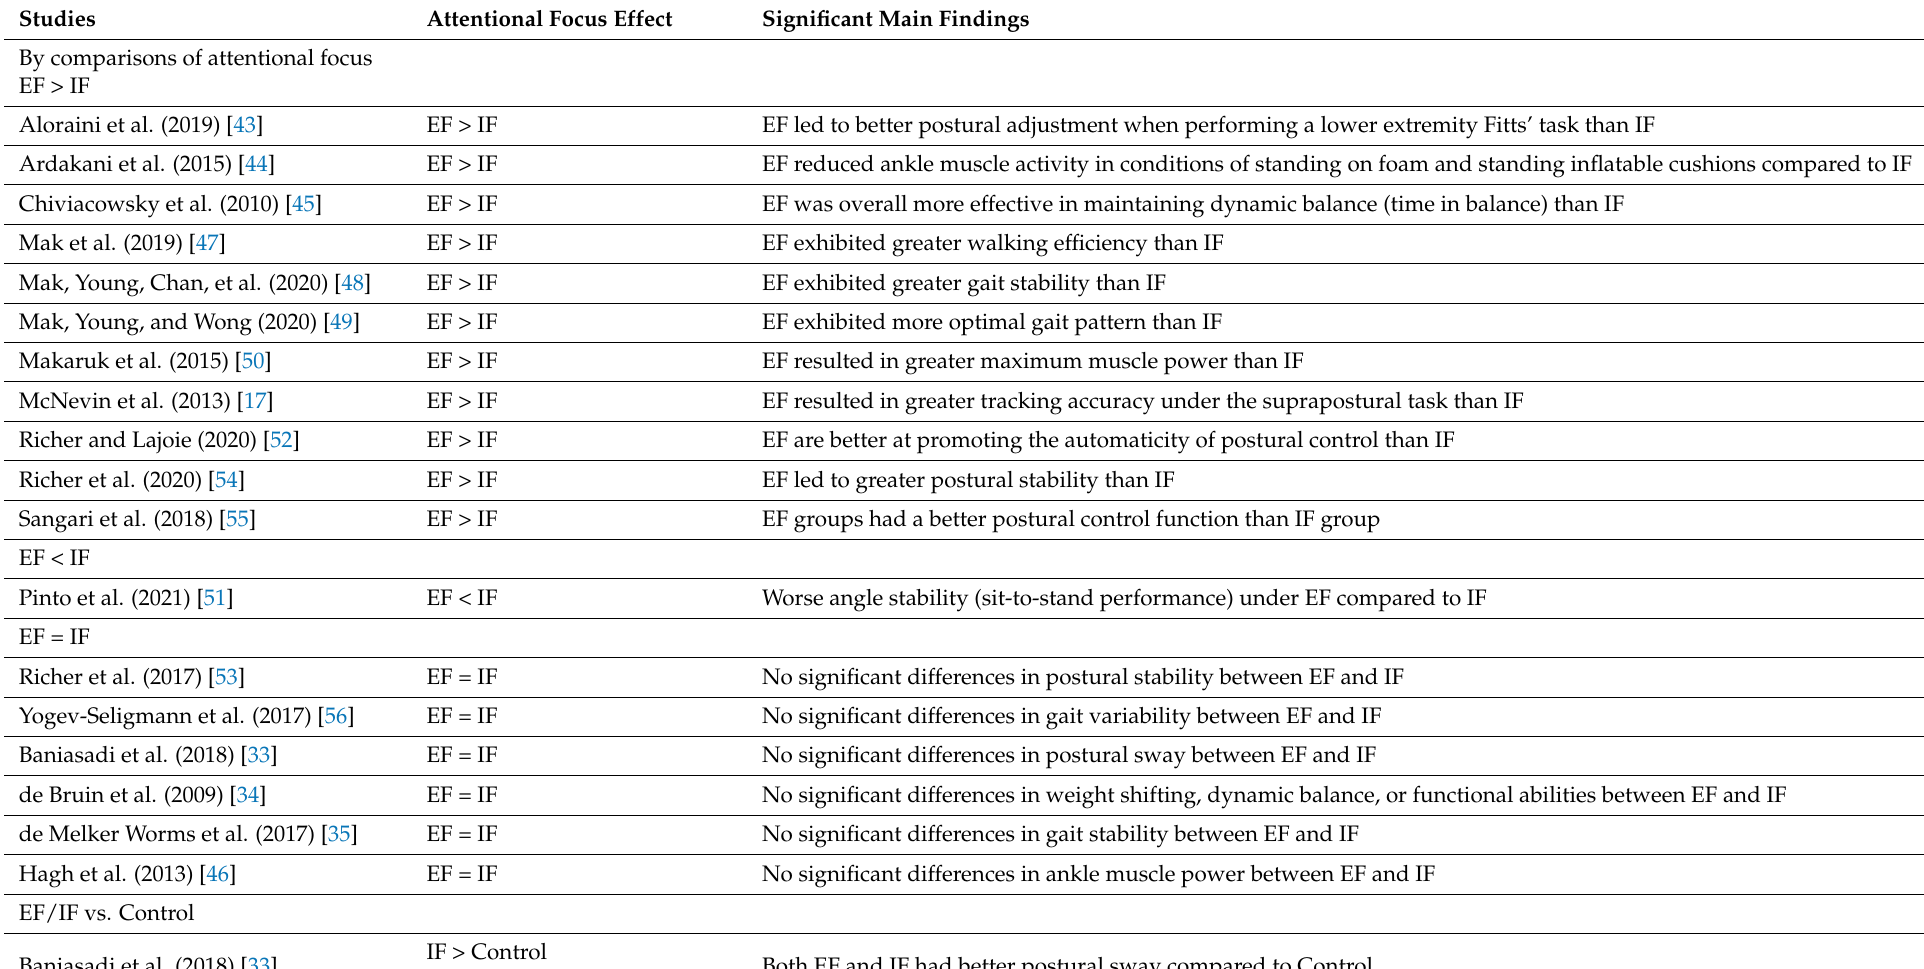
Table 4. Summary of the Results of the Reviewed